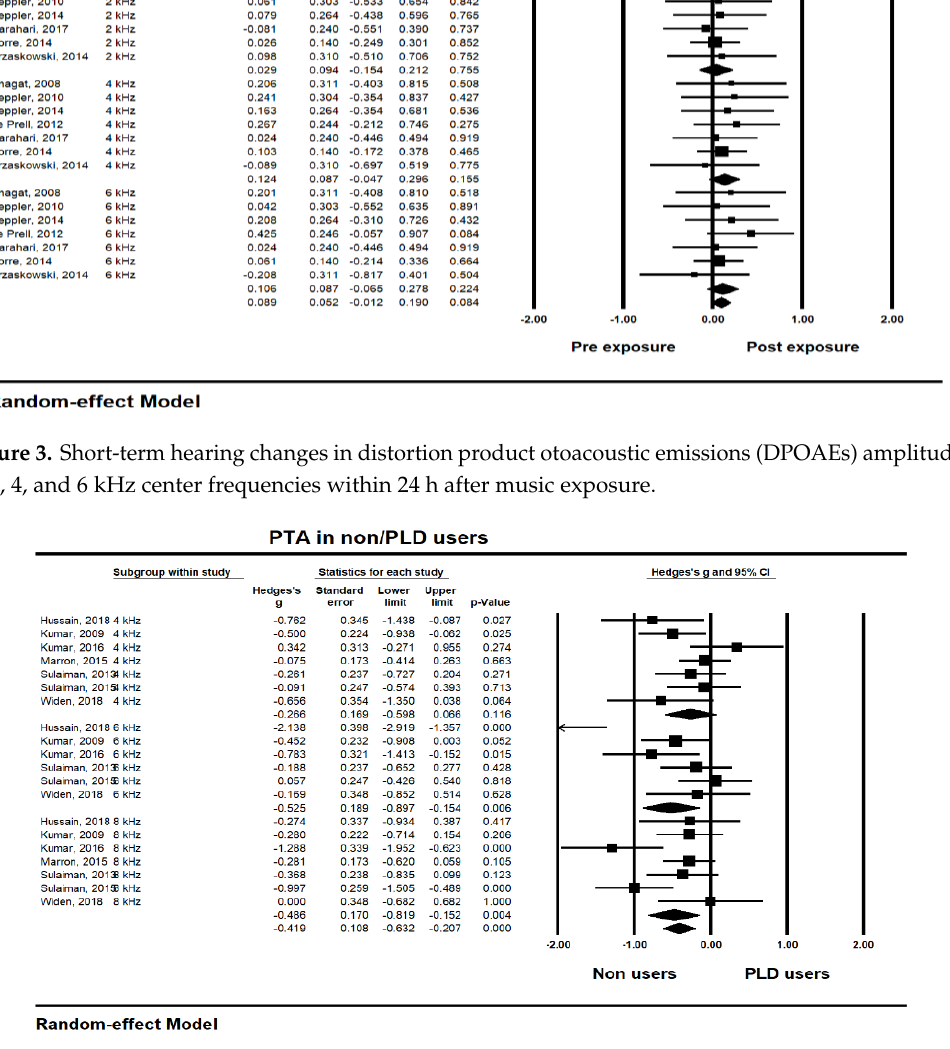
Figure 4. Long-term hearing changes of pure tone audiometry (PTA) thresholds at 4, 6, and 8 kHz after music exposure.